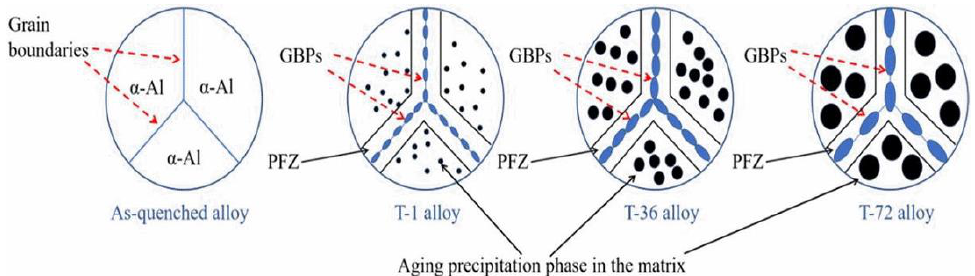
Figure 11. Schematic diagram of the microstructure evolution of alloys during aging at 180 °C (T-1, T-36, T-72 indicate aging for 1 h, 36 h and 72 h, respectively) (the four pictures represent the solid solution state, under-aging state, peak aging state and over-aging state, respectively) [33].